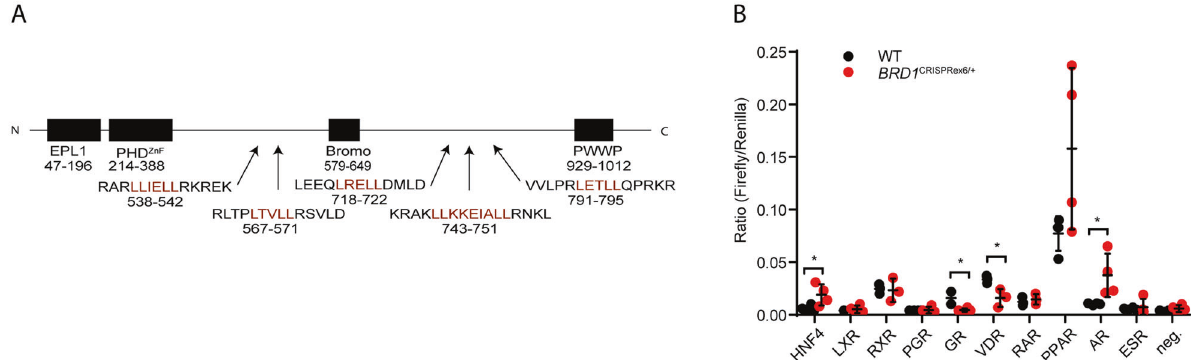
Fig. 3 Analysis of the transcriptional drive of hormone response elements (HRE) in BRD1 CRISPRex6/ + cells. A Domains and nuclear receptor binding sites in BRD1. Top: Enhancer of polycomb-like, N-terminal domain (EPL1); Plant homeodomain fi nger (PHD ZnF ); Bromodomain (Bromo); Pro-Trp-Trp-Pro (PWWP). Bottom: Amino acid sequences (one-letter code) containing putative nuclear receptor (NR) binding sites (4 co-activators (LXXLL) and 1 co-repressor (LXXIXXL)). Pink letters indicate the putative NR binding sites. Amino acid numbering according to BRD1-S. B Transcription from promoters containing HREs recognized by respectively: HNF4 (hepatocyte nuclear factor); LXR (liver receptor); RXR (retinoid X receptor); PGR (progesterone receptor); GR (glucocorticoid receptor); VDR (vitamin D receptor); RAR (retinoic acid receptor); PPAR (peroxisome proliferator-activated receptor); AR (androgen receptor); and ESR (estrogen receptor) as well as a TATA box promoter (negative control (neg)) was tested in four distinct BRD1 CRISPRex6/ + and four WT HEK cell lines by a dual luciferase-based array. P -value as determined by Student ’ s t -tests. p < 0.05 (*). Transcription from the PPAR HRE (PPRE)-containing promoter was near signi fi cantly increased ( p = 0.085) in BRD1 CRISPRex6/ +